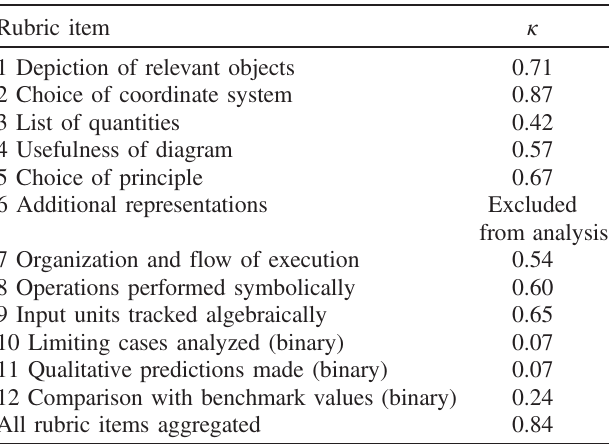
TABLE II. Interrater reliability for rubric scores.